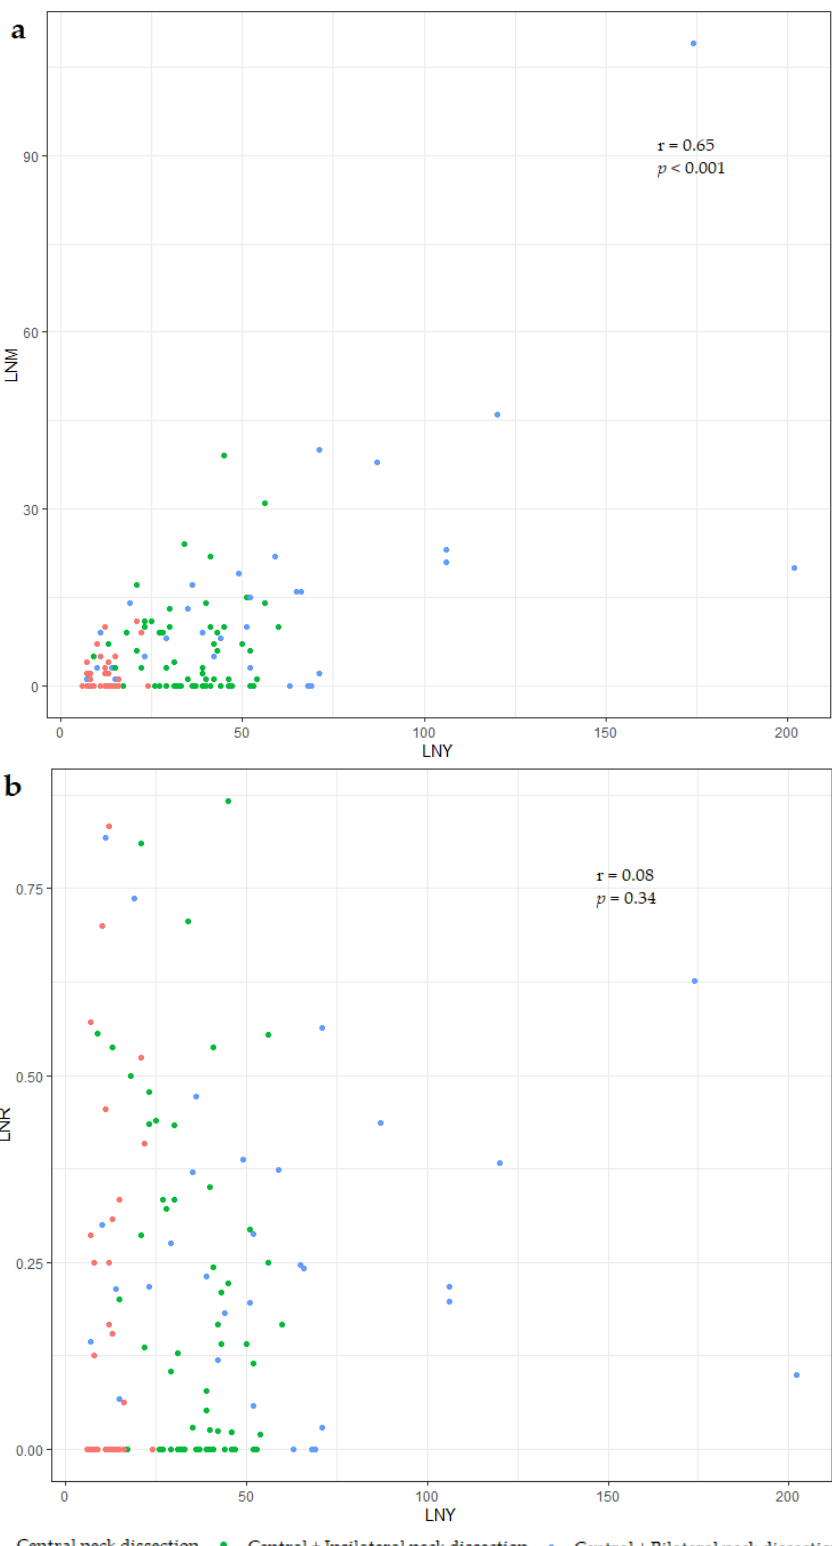
Figure 2. Relationship between lymph node metastases (LNMs) and the number of lymph nodes resected or lymph node yield (LNY). LNM and LNY were significantly related ( a ). Meanwhile, the relationship between lymph node ratio (LNR) and lymph node yield (LNY) was distributed independently ( b